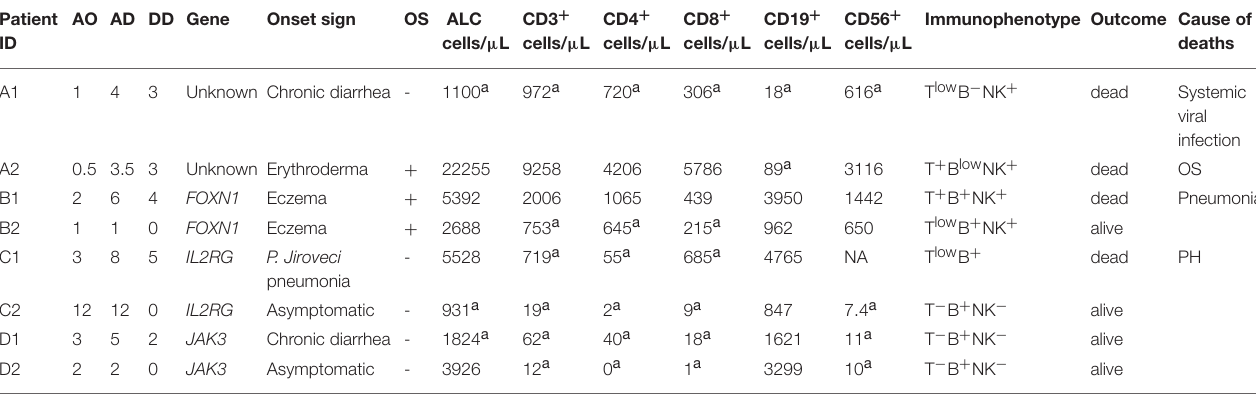
TABLE 6 | Clinical and immunological features of SCID siblings. Patient